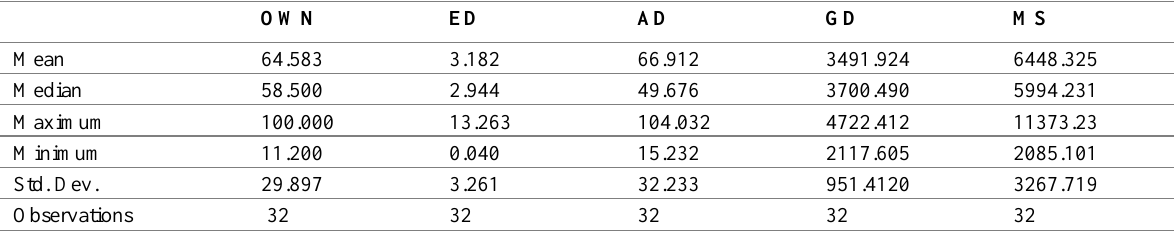
Table 2: Descriptive Statistical